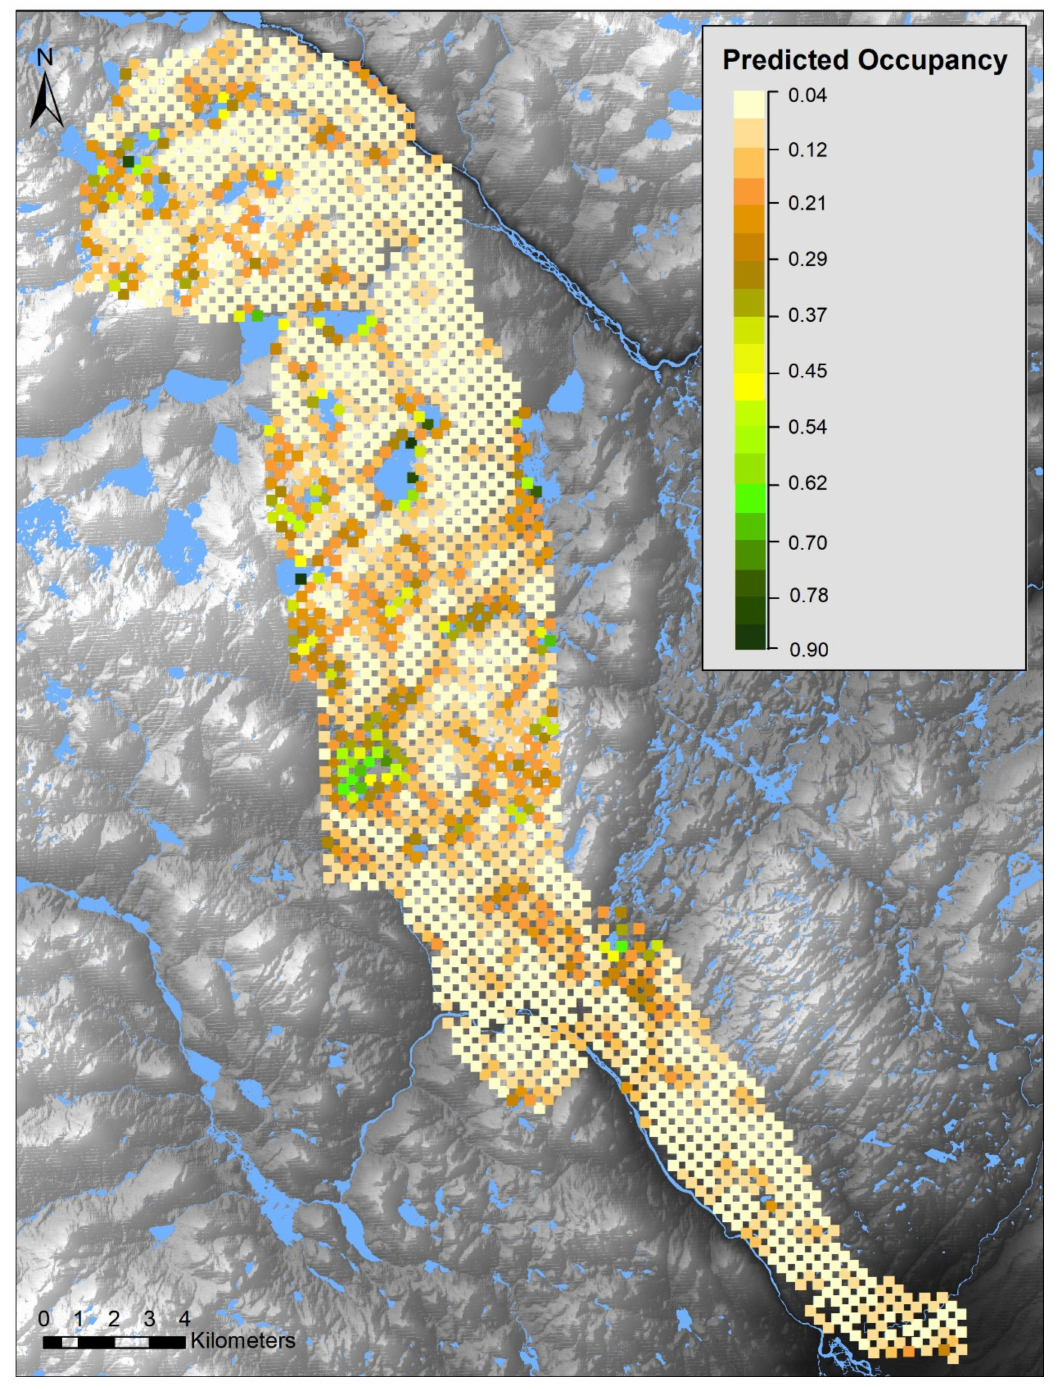
Figure 3. Probability of rusty blackbird occupancy mapped across our study area in Newfoundland, Canada, in 2016 and 2017. Probability of occupancy was estimated from our best model (Table 3) based on landcover data available in the provincial forest resource inventory and publicly available national CanVec stream